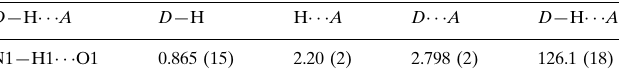
Hydrogen-bond geometry (A˚ , (cid:2)